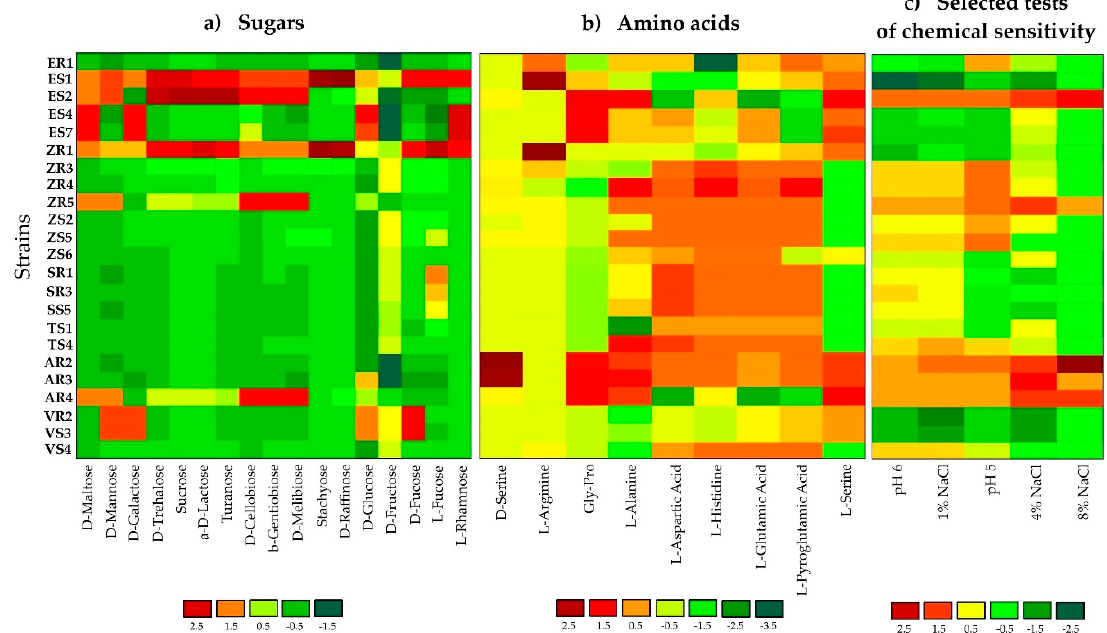
Figure 1. Heatmap of 23 strains showing physiological profiles for ( a ) sugars, ( b ) amino acids and ( c ) selected tests for chemical sensitivity after 120 h of incubation. The relative utilization of selected substrates is depicted by color intensity, based on the legend next to the figure. The highest consumption can be identified by a red color and the lowest consumption by a green